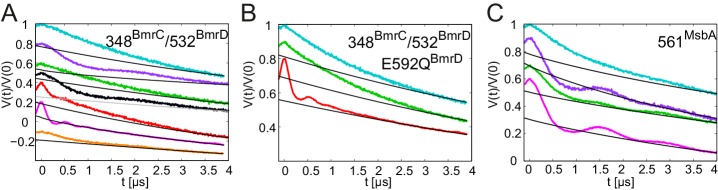
DEER analysis of BmrCD and MsbA.Q-band primary DEER traces [V(t)/V(0)] with fitted background for the spin-labeled pair 348BmrC/532BmrD in (A) wildtype BmrCD and (B) in BmrCD containing the E-to-Q mutation; (C) data for the spin-labeled pair 561MsbA in wildtype MsbA. Color coding as in Figure 9.